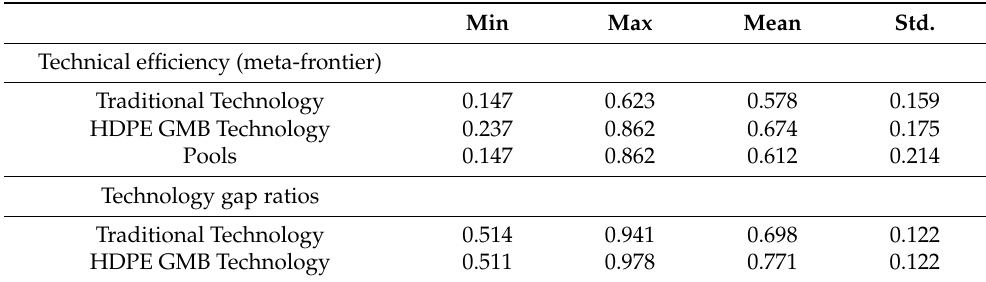
Table 6. Summary statistics for the technical efficiencies obtained the meta-frontier models for sea salt farm production. Min